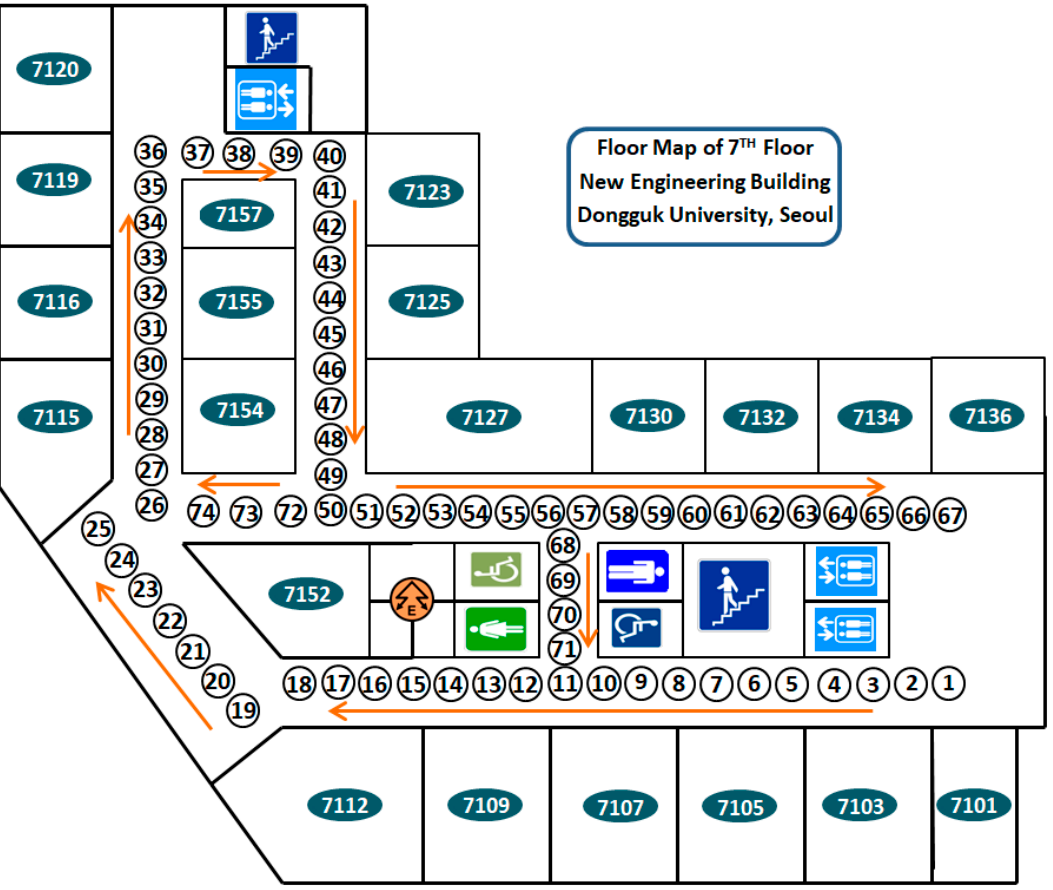
Figure 3. Environment setup for floor map with 74 reference points.